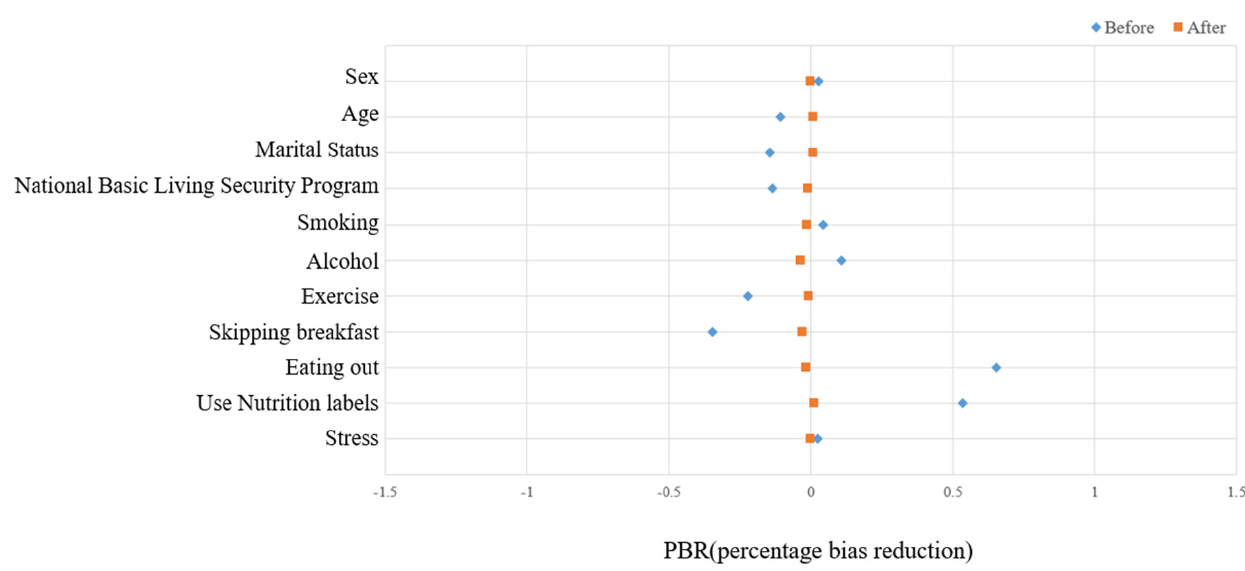
Figure 2. Covariates imbalance before and after propensity score matching.